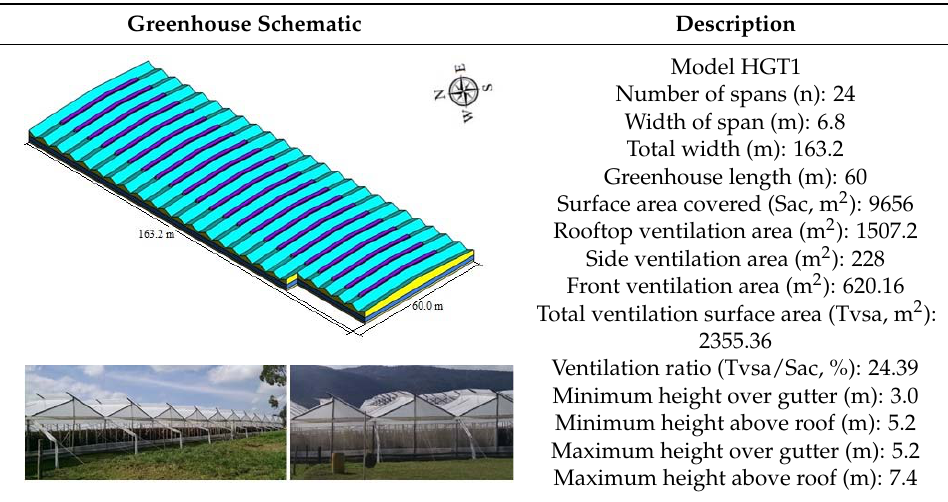
Table 3. General characteristics of the HGT1 greenhouse.